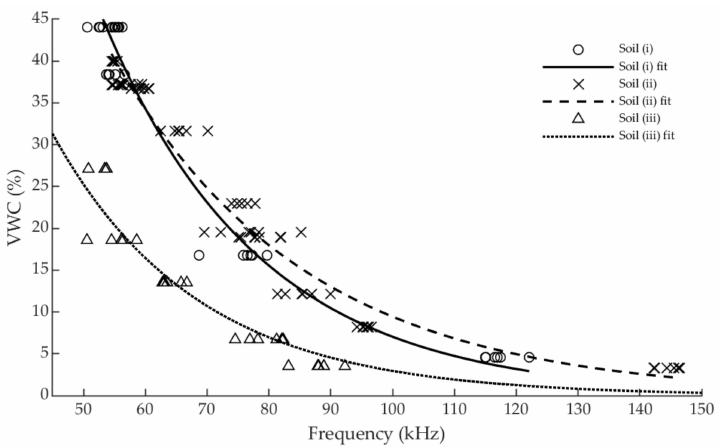
Figure 5. Sensor measurements and calibration curves in the three soils.